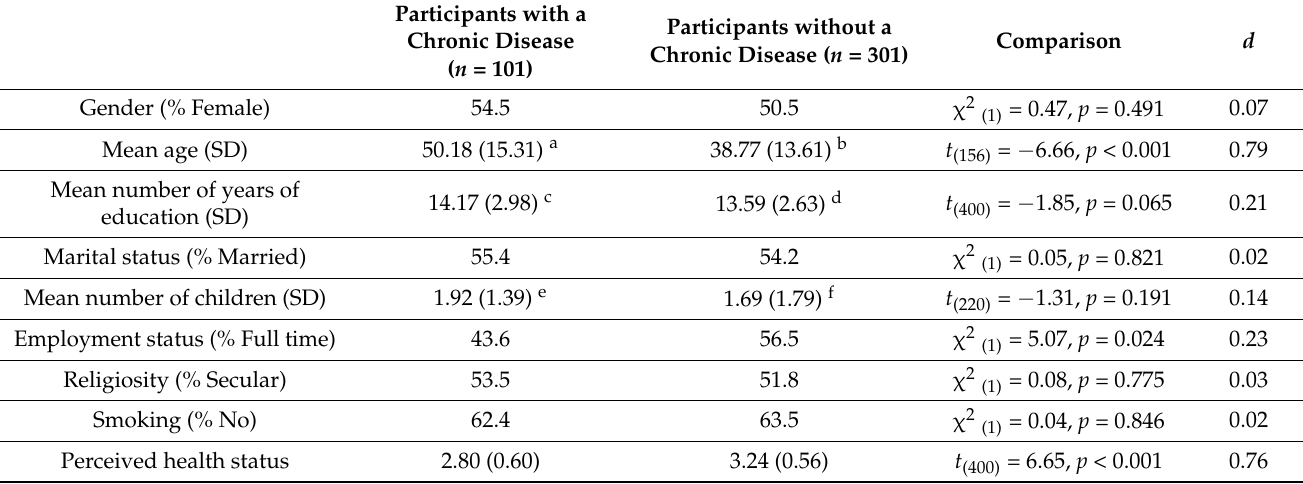
Table 1. Participants’ sociodemographic